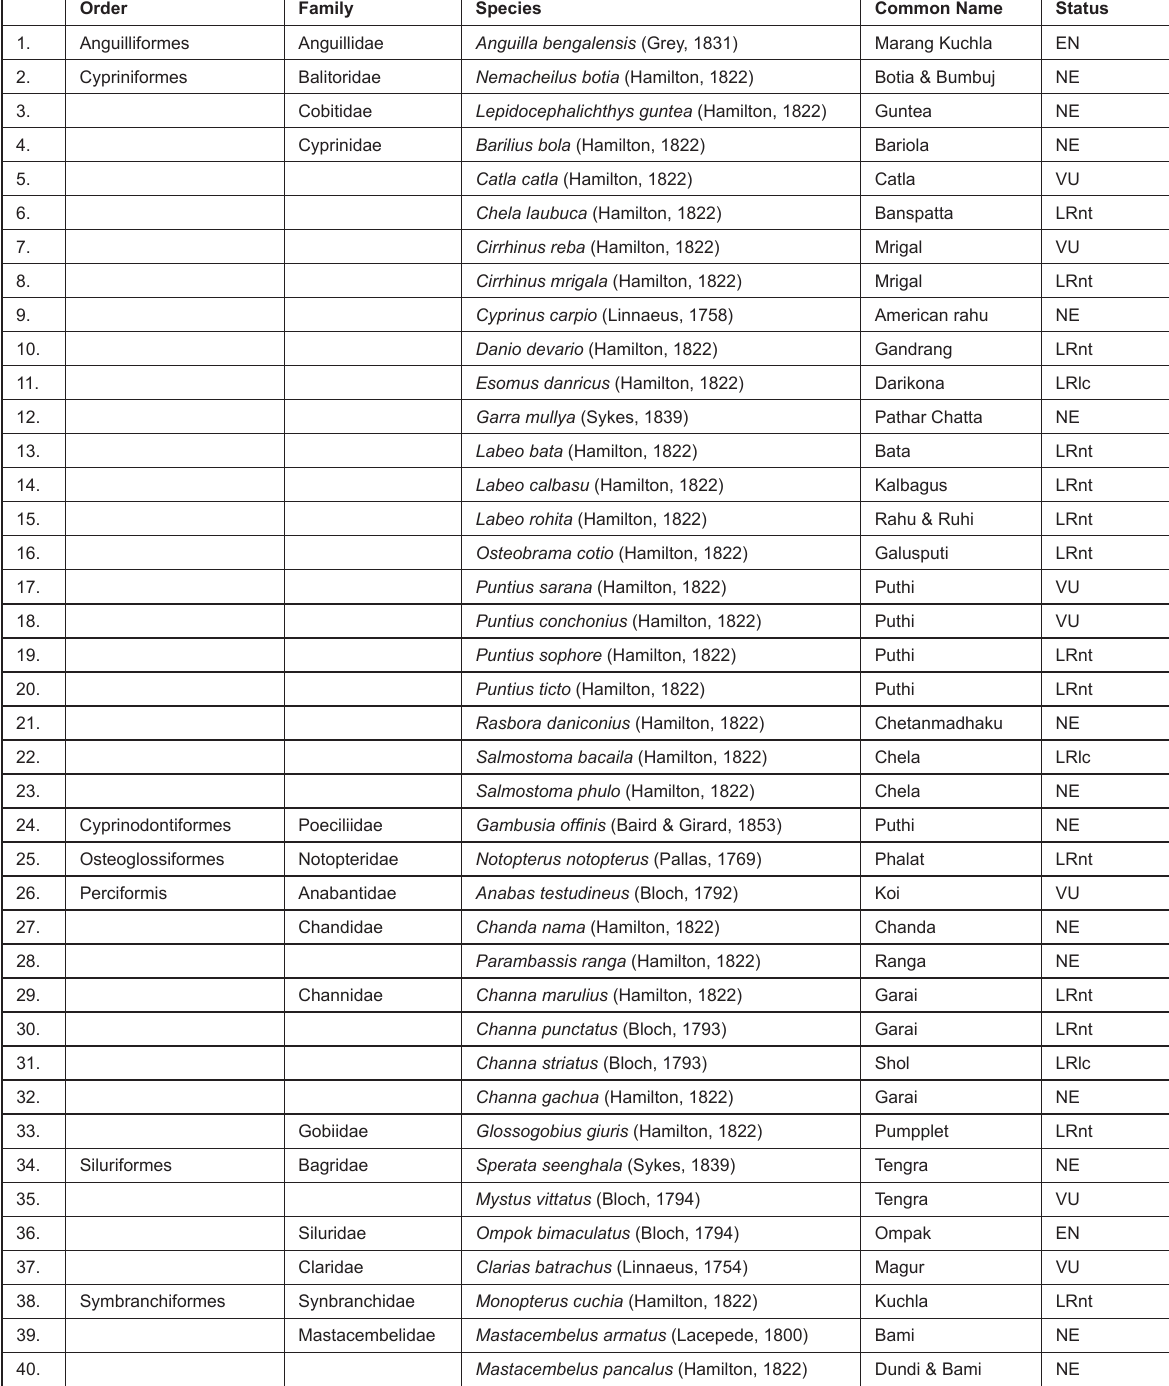
Table 1. Systematic list of fishes with local name and their conservation status (Molur & Walker